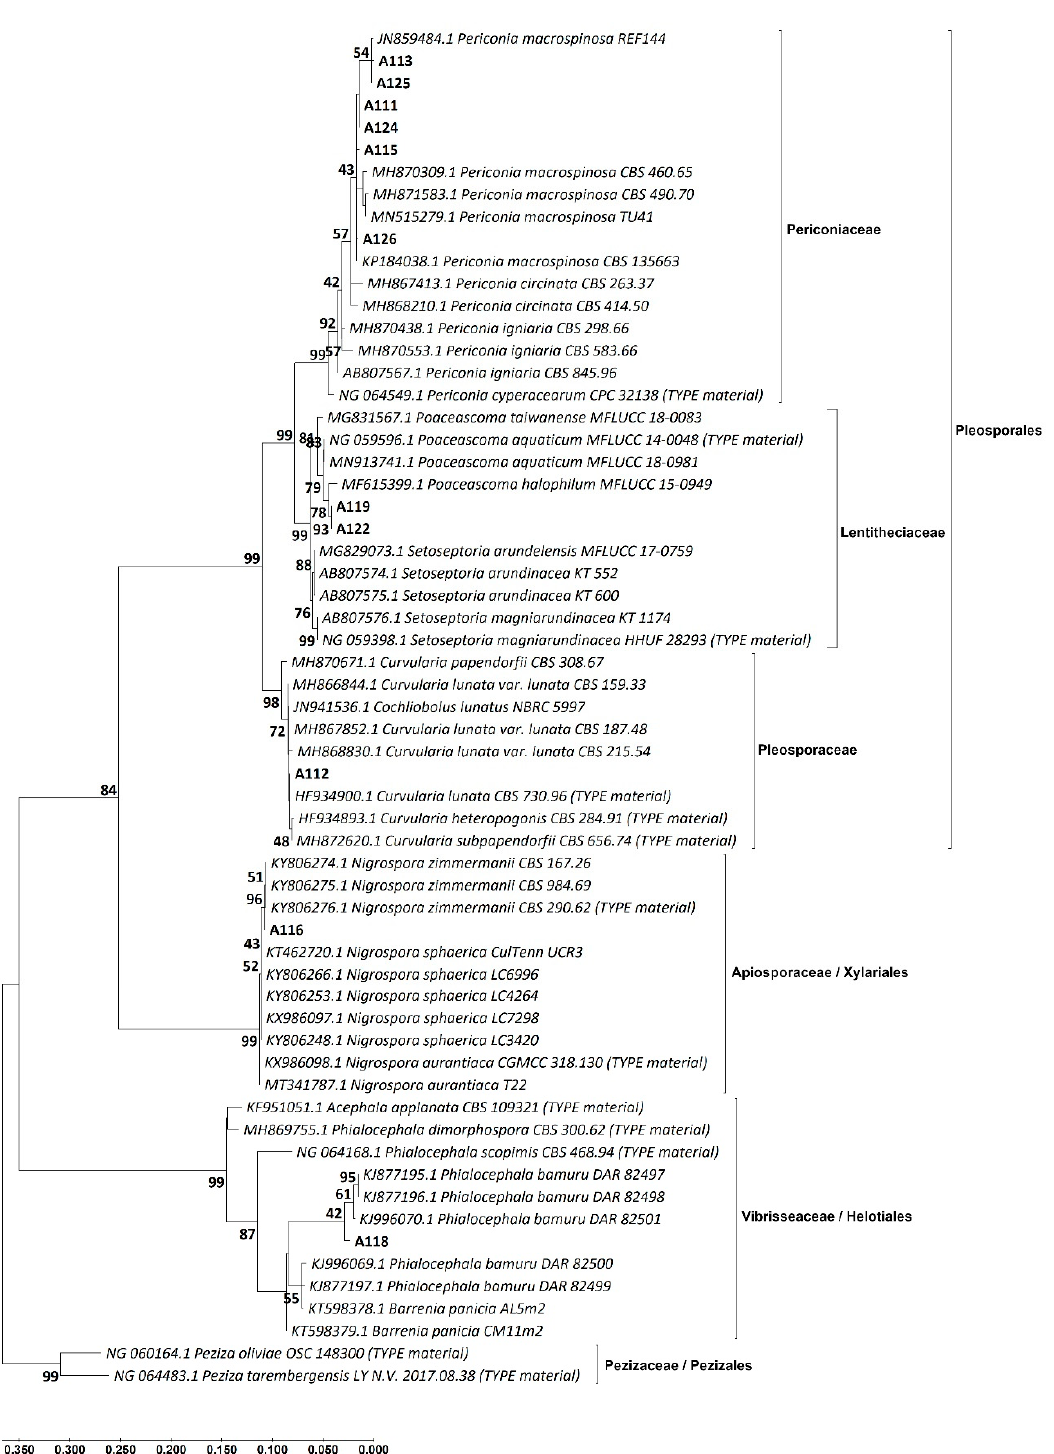
Figure 7. Phylogenetic tree of the large subunit (LSU) region of dark septate endophytic fungi isolated from sugarcane roots (in bold) and similar sequences from GenBank. Two Peziza species were added as outgroup references. Tree inferred by the maximum likelihood method and general time reversible model with the highest log likelihood ( − 8253.44). Branch lengths analysis involved 61 nucleotide sequences of a total of 1889 positions in dataset. Numbers next to the branches indicate the percentage of replicate trees in which the associated taxa clustered together (5000 replicates bootstrap test).